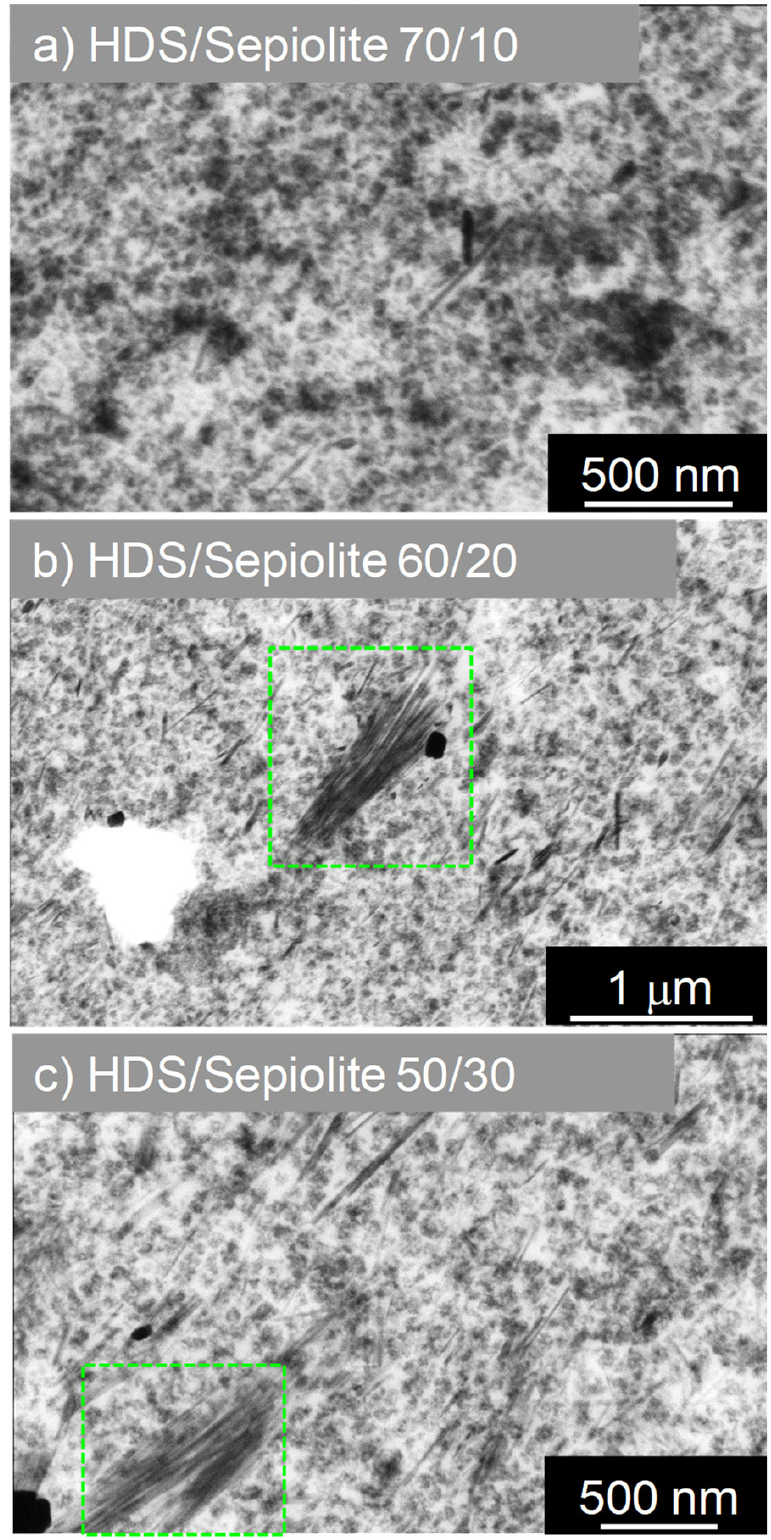
Figure 2. STEM images of nanocomposites synthesized with dual filler: ( a ) HDS/Sepiolite ‐ 70/10, ( b ) HDS/Sepiolite ‐ 60/20 (60/20), ( c ) HDS/Sepiolite ‐ 50/30.